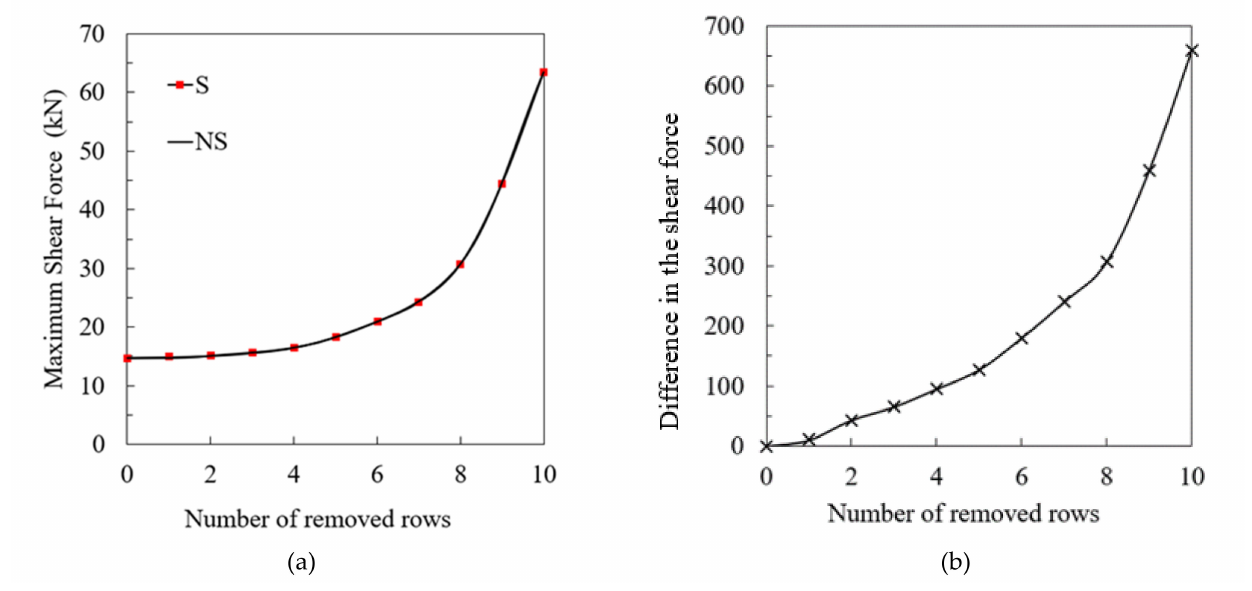
Figure 9. Stud fracture effect on the maximum shear force. ( a ) Maximum shear force. ( b ) Difference in the maximum shear force due to post-tensioning.